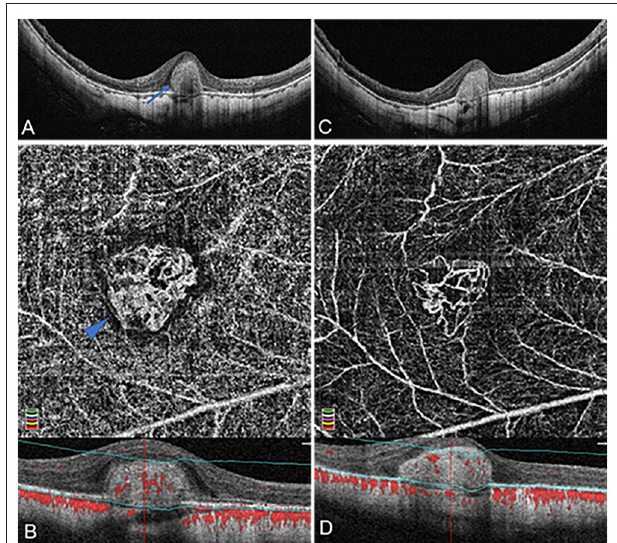
FIGURE 2 | Organized interlacing pattern of active mCNV imaged by OCT and OCTA before and after anti-VEGF injection in Patient #15, a 49-year-old man (refractive error − 14.75 diopters) in the right eye. OCTA segmentation was manually adjusted to acquire a clear en face image visualizing the entire thickness mCNV lesion. (A) Spectral-domain OCT B-scan at baseline showed a typical subretinal hyper-reflective type-2 CNV (blue arrow) with discontinuous retinal pigment epithelium (RPE). (B) OCTA en face image (3 × 3mm) at baseline depicted a larger, well-circumscribed, interlacing type of neovascular membrane. This mCNV lesion contained numerous tiny capillary ramifications, anastomoses and loops, which was bordered by a dark halo, showing a medusa shape (blue arrowhead). (C) One month after the first injection, OCT image revealed significant shrinkage of CNV lesion with a clearer contour. (D) One month after the first injection, OCTA en face image (3 × 3mm) indicated a reduction of CNV size, anastomoses, and perilesional halo, a dramatic attenuation of capillaries and small caliber vessels, and a reservation of large caliber vessels. The lower parts of image (B,D) represented the cross-sectional structural OCT images corresponding to the upper OCTA en face images, respectively, displaying the boundaries (green lines) of the OCTA slabs after manual adjustment of